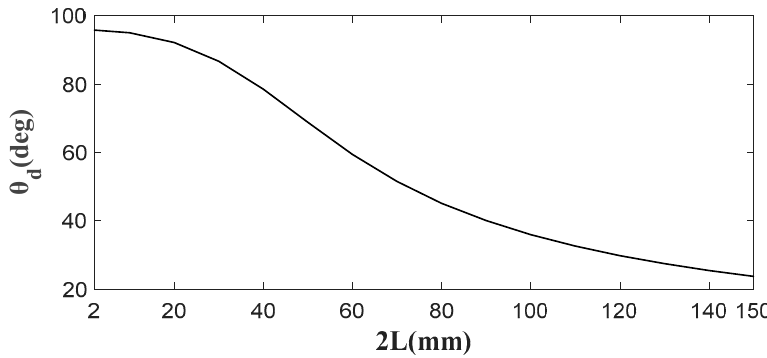
Figure 6. The relationship between the divergence angles of the main lobes and the lengths of the MSTs.